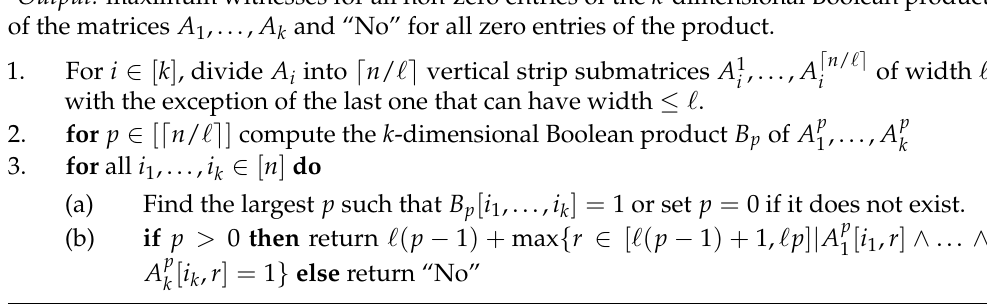
Algorithm 1 Generalize the multiplication of rectangular submatrices of the input matrices to include the maximum witness problem for the k -dimensional Boolean matrix